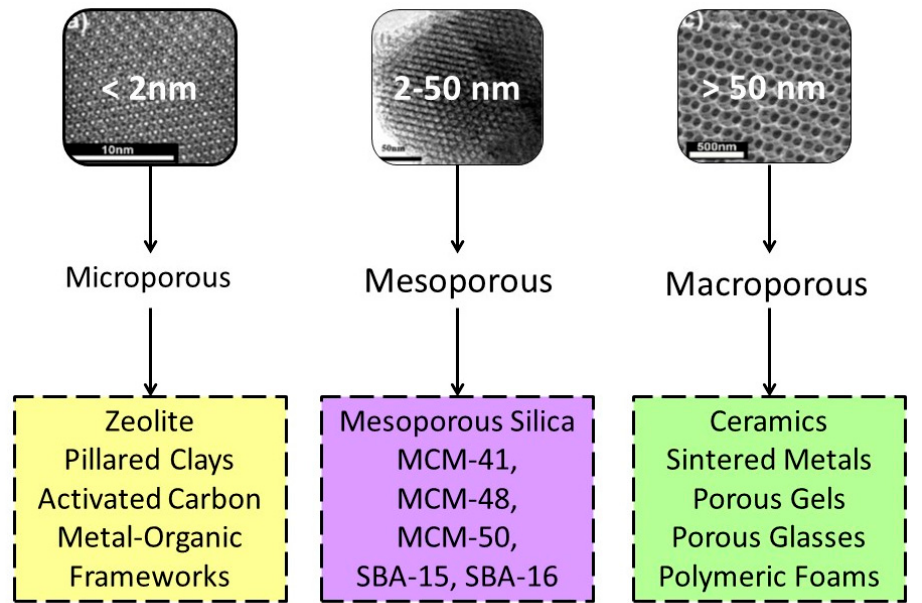
Figure 10. IUPAC classification of porous materials: microporous, mesoporous and macroporous structures. MCM (Mobil Composition of Matter) and SBA ( Santa Barbara Amor- phous ).